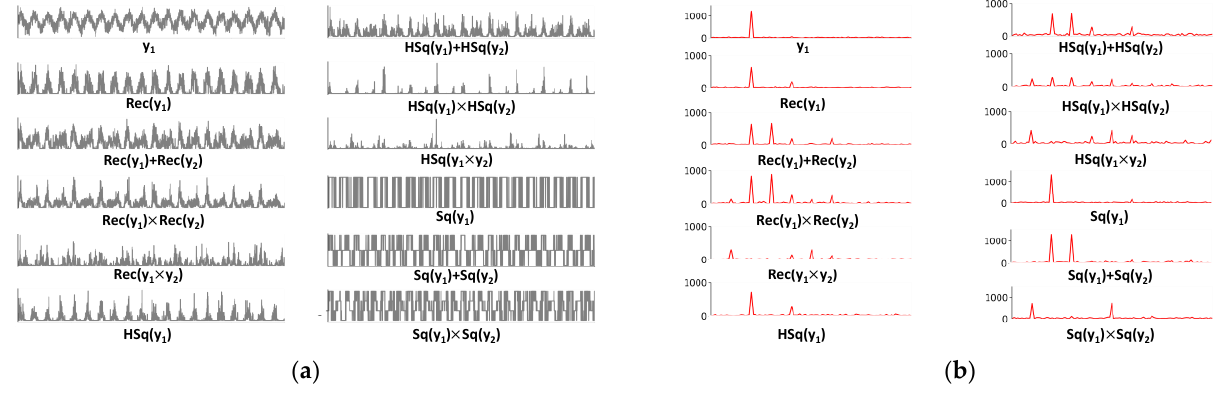
Figure 5. Examples of different nonlinear processing functions in the time domain and frequency domain . ( a ) Waveforms in the time domain (0 to 5 s). 𝑦 1 and 𝑦 2 are sinusoidal inputs at 4 Hz and 6 Hz, respectively. See text for definitions of Rec, HSq and Sq. ( b ) Spectra of each waveform in the frequency domain. Table 2. Candidate models are used for model comparison. a, b and c denote the weights of the